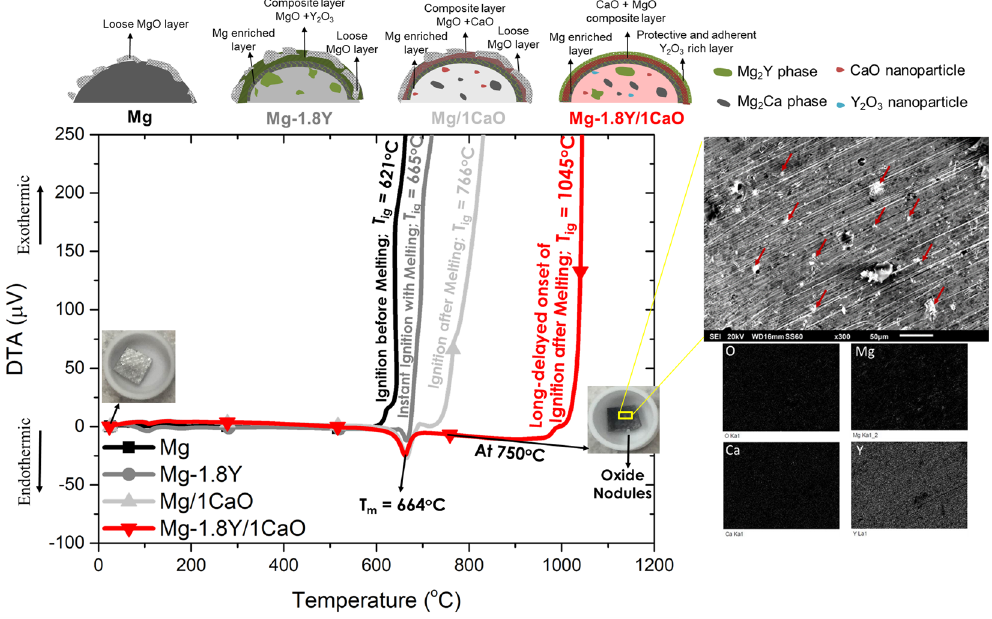
Figure 4. Schematic of DTA vs Temperature of all the materials. Endothermic peak indicates the melting temperature of the materials. Mg curve represents ignition before melting due to the presence of loose MgO layer; Mg-1.8Y alloy shows instant ignition with melting due to the presence of Y 2 O 3 rich oxide scale; Mg/1CaO ignites after melting due to a more protective CaO + MgO scale and Mg-1.8Y/1CaO nanocomposite with the presence of multiple secondary phases and nanoparticles (not drawn to scale) developed in-situ develops a completely protective oxide layer that exhibits long-delayed onset of ignition. An inset of the sample heated until 750 °C in TGA and cooled down to room temperature shows an unignited Mg-1.8Y/1CaO. X ray mapping of the image indicates the dominating continuous presence of Y 2 O 3 with a distributed presence of CaO and MgO layer on the surface indicating a Y 2 O 3 rich